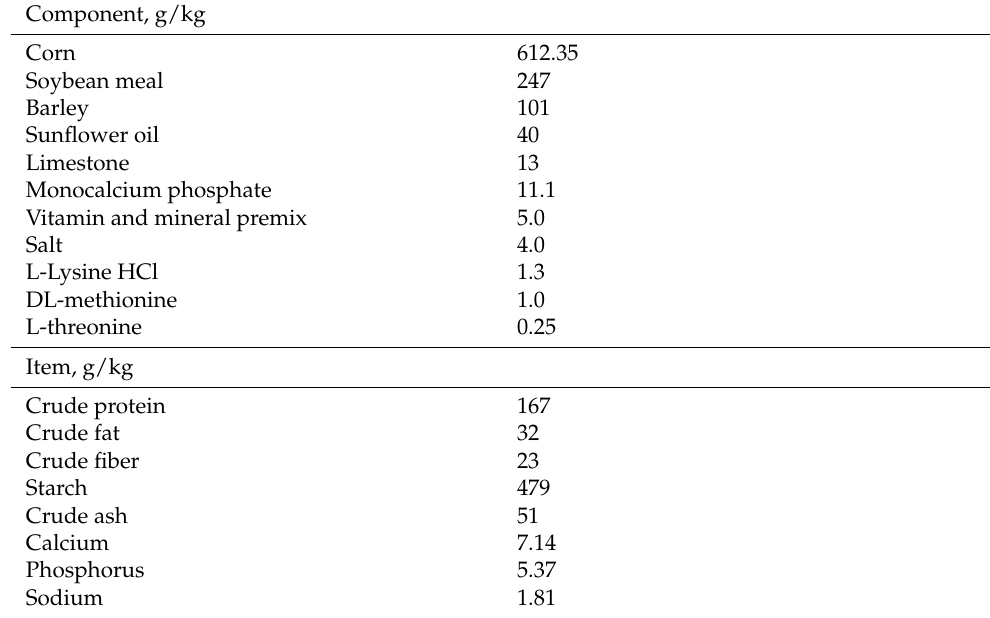
Table 1. Feed composition and analyzed proximate composition of feed.